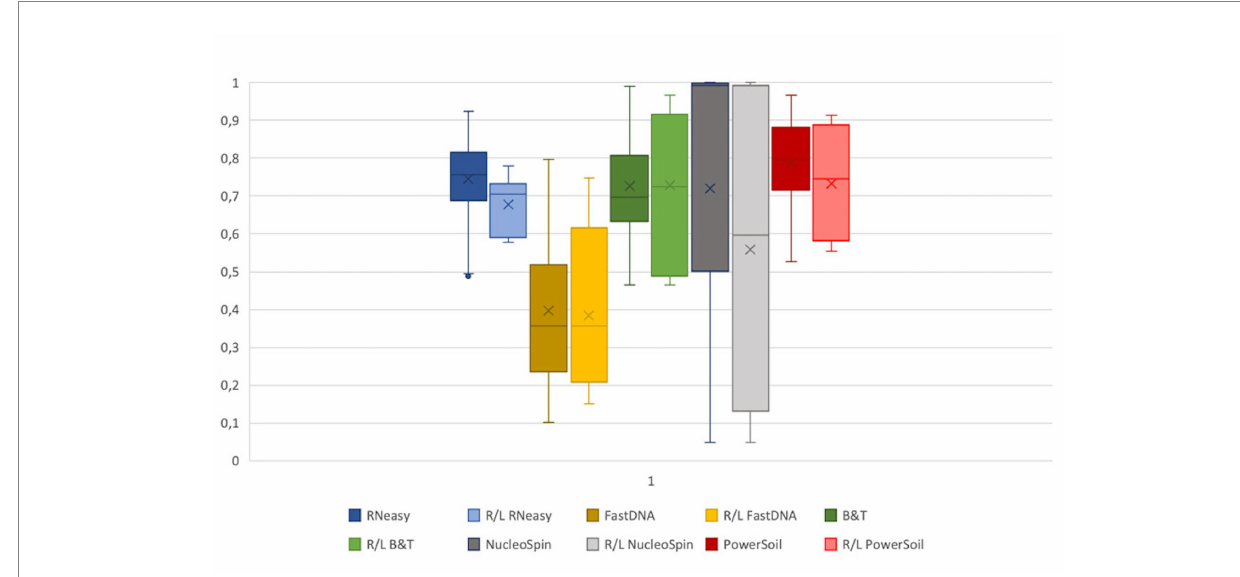
FIGURE 5 Extraction protocol repeatability. The Bray-Curtis distances of the samples analysed with a certain extraction protocol were visualized next to the distance of the right and left eye of every volunteer per protocol. The distance between all samples analysed with a certain protocol were not significantly different from the distance between the right and left eye. Based on the within subject distance, FastDNA is the most repeatable (0.39 ± 0.2), followed by NucleoSpin (0.56 ± 0.37) and RNeasy (0.68 ±